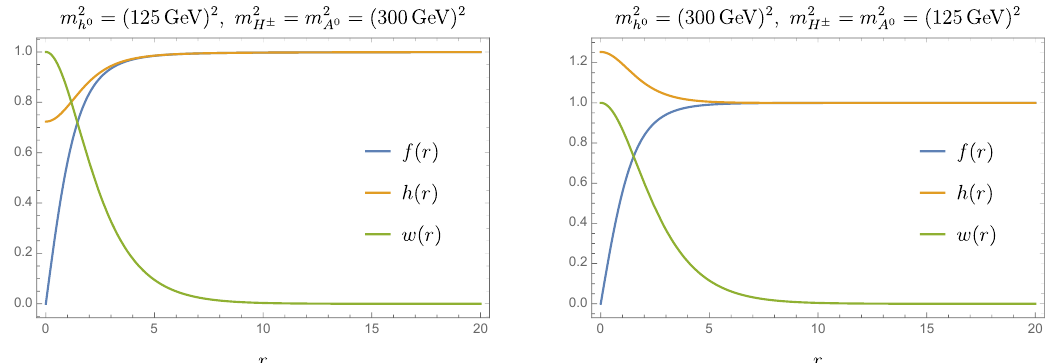
Figure 1 . Plot of the profile functions obtained by solving the EOMs numerically. The custodial SU(2) C symmetry is imposed. The masses of the gauge bosons are fixed as m Z = 91 GeV and m W = 80 GeV . We take a length unit such that v = 123 GeV = 1 . The condensation of h ( r ) at the center of the string becomes larger when m is larger than the other masses (right h 0